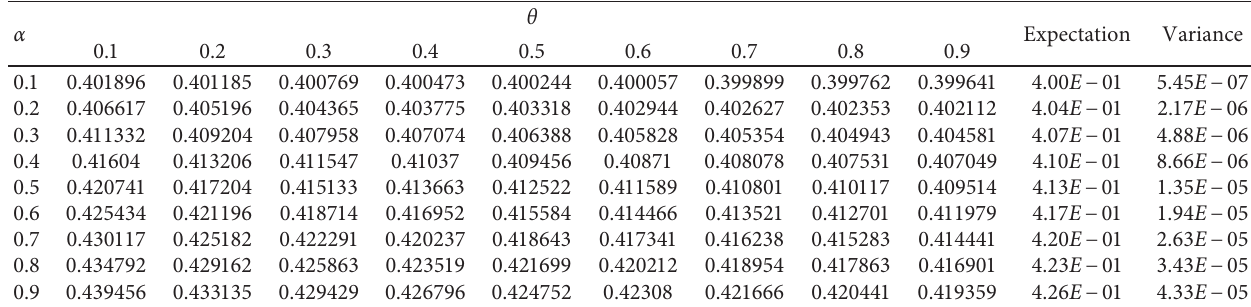
A under the BA network.